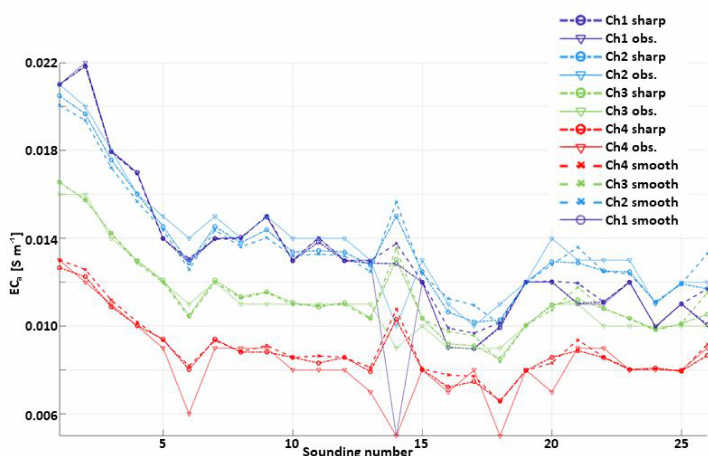
Figure 5. Comparison of the data fitting associated with the sharp and smooth inversions applied to the dataset 50-6dS (Fig. 4). The calculated data corresponding to the sharp and smooth results are shown together with the observations for each of the four measured channels